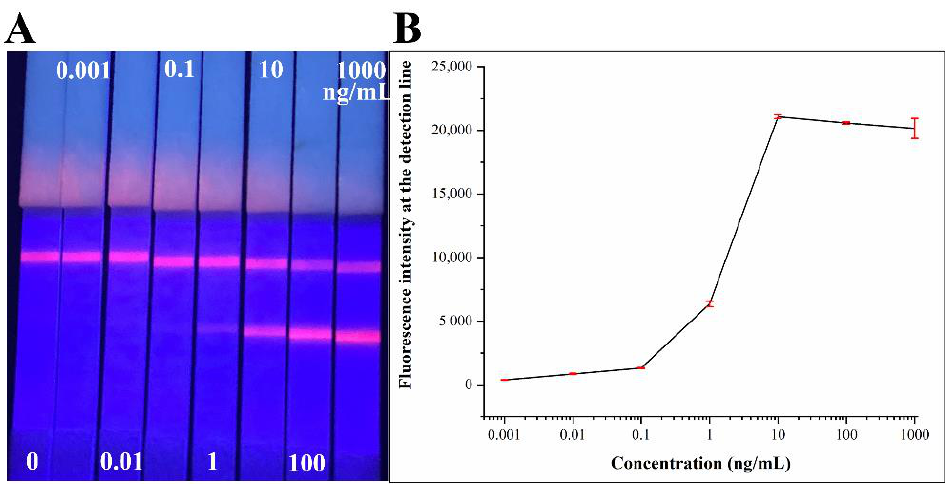
Figure 6. The test results of COVID-19 N protein standards using LFIA strips. ( A ) Images of corresponding concentrations tested COVID-19 N protein LFIA strips under 365 nm ultraviolet light. ( B ) Different concentrations of COVID-19 N protein standards measured by the fluorescence strip scan- ning device.